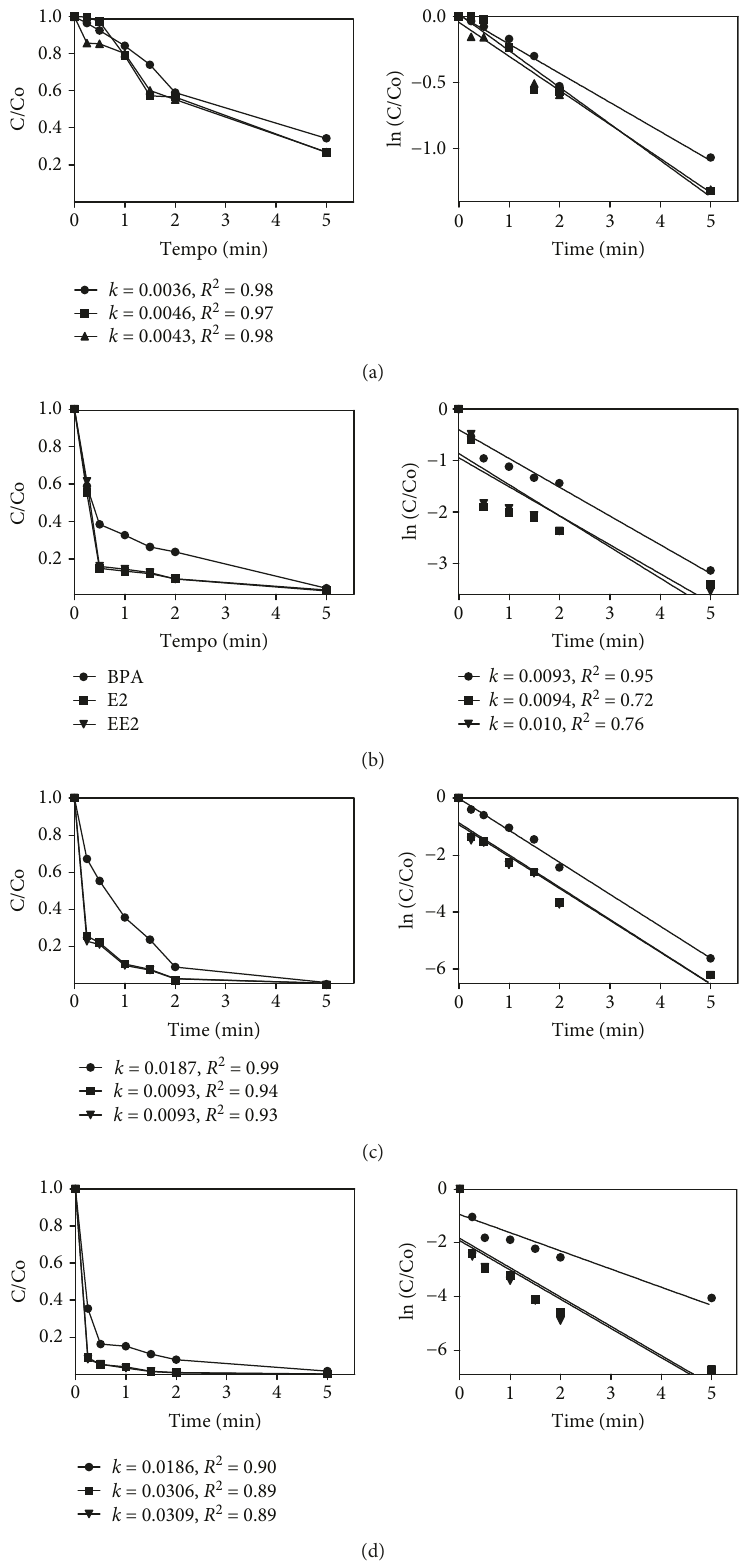
Figure 2: EDC photodegradation and respective pseudo- fi rst-order rate constants (seconds) by Cl/UVC in ultrapure water under di ff erent chlorine concentrations: (a) 0.2mg · L -1 ; (b) 1mg · L -1 ; (c) 1.5mg · L -1 ; (d) 2.0mg · L -1 . Initial EDC concentrations: 100 μ g · L -1 , UVC irradiance =14.79mW cm -2 , T =25 ° C, pH=7, reaction time: 5